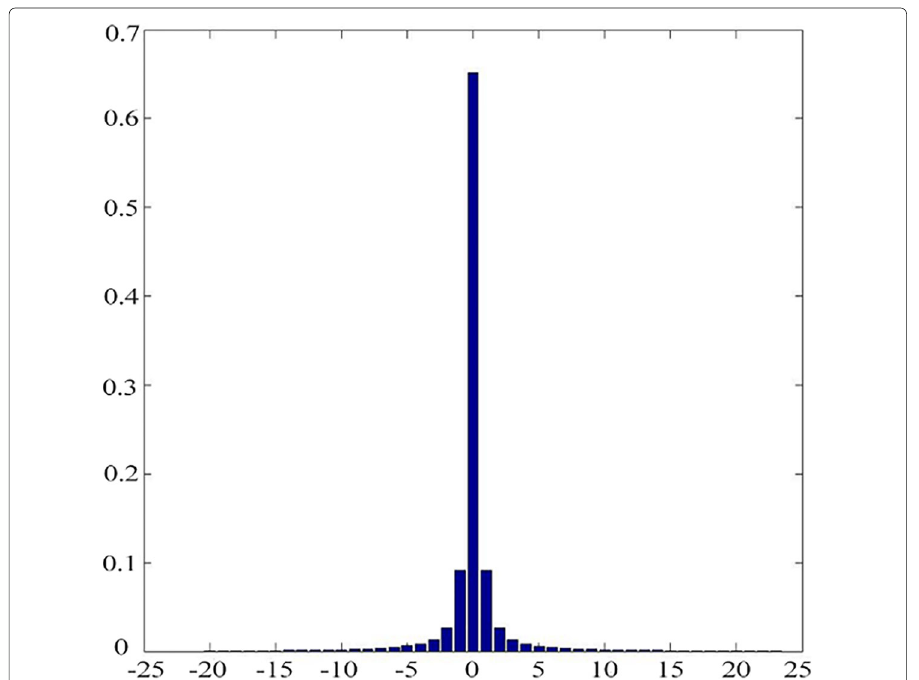
Fig. 3 Histogram of the quantized DCT coefficients in a JPEG